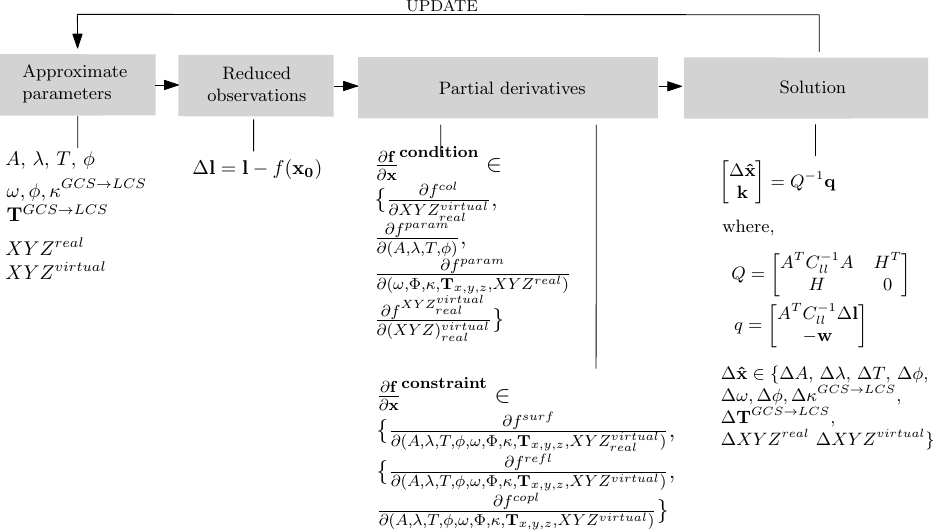
Figure 6. Graphical representation of the functional model. The camera captures the scene following the laws of perspective projection. The wave model, displayed at a time instance, is defined through parameters A , λ , T and φ in LCS . The camera ( O ), the virtual point P and real point R lie on a common plane π , whereas the incident and reflecting rays are symmetric w.r.t. the normal N .